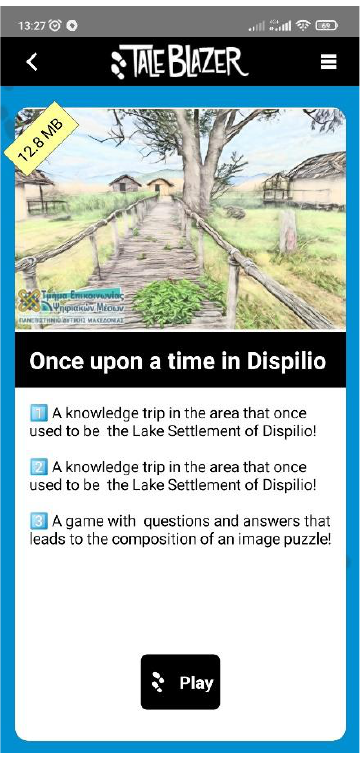
Figure 5. Initial screen of the game.